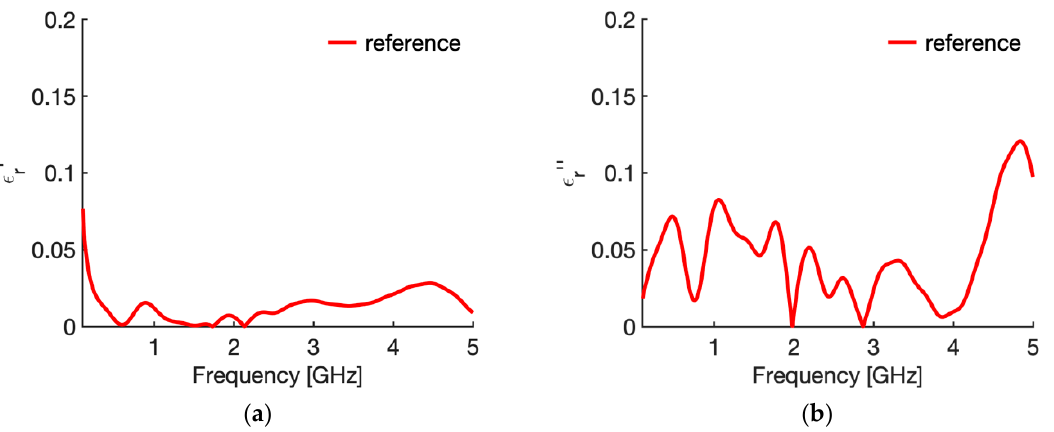
Figure 5. Relative complex permittivity of fat at 25 °C. ( a ) real part; ( b ) imaginary part. The values implemented into the CST software (red line) are compared with those reconstructed by the Stuchly’s model (dashed blue line) from the simulated reflection coefficient of the open probe.